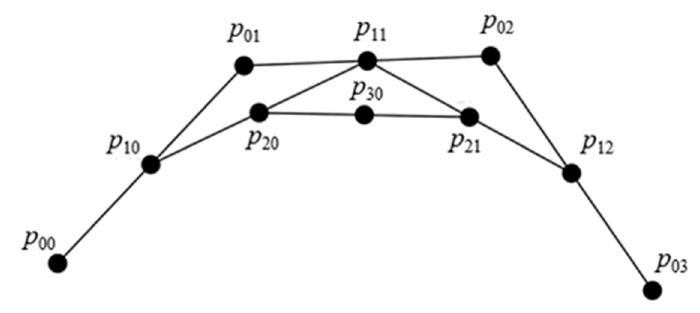
Figure 11. Control points of the cubic Bézier curve.